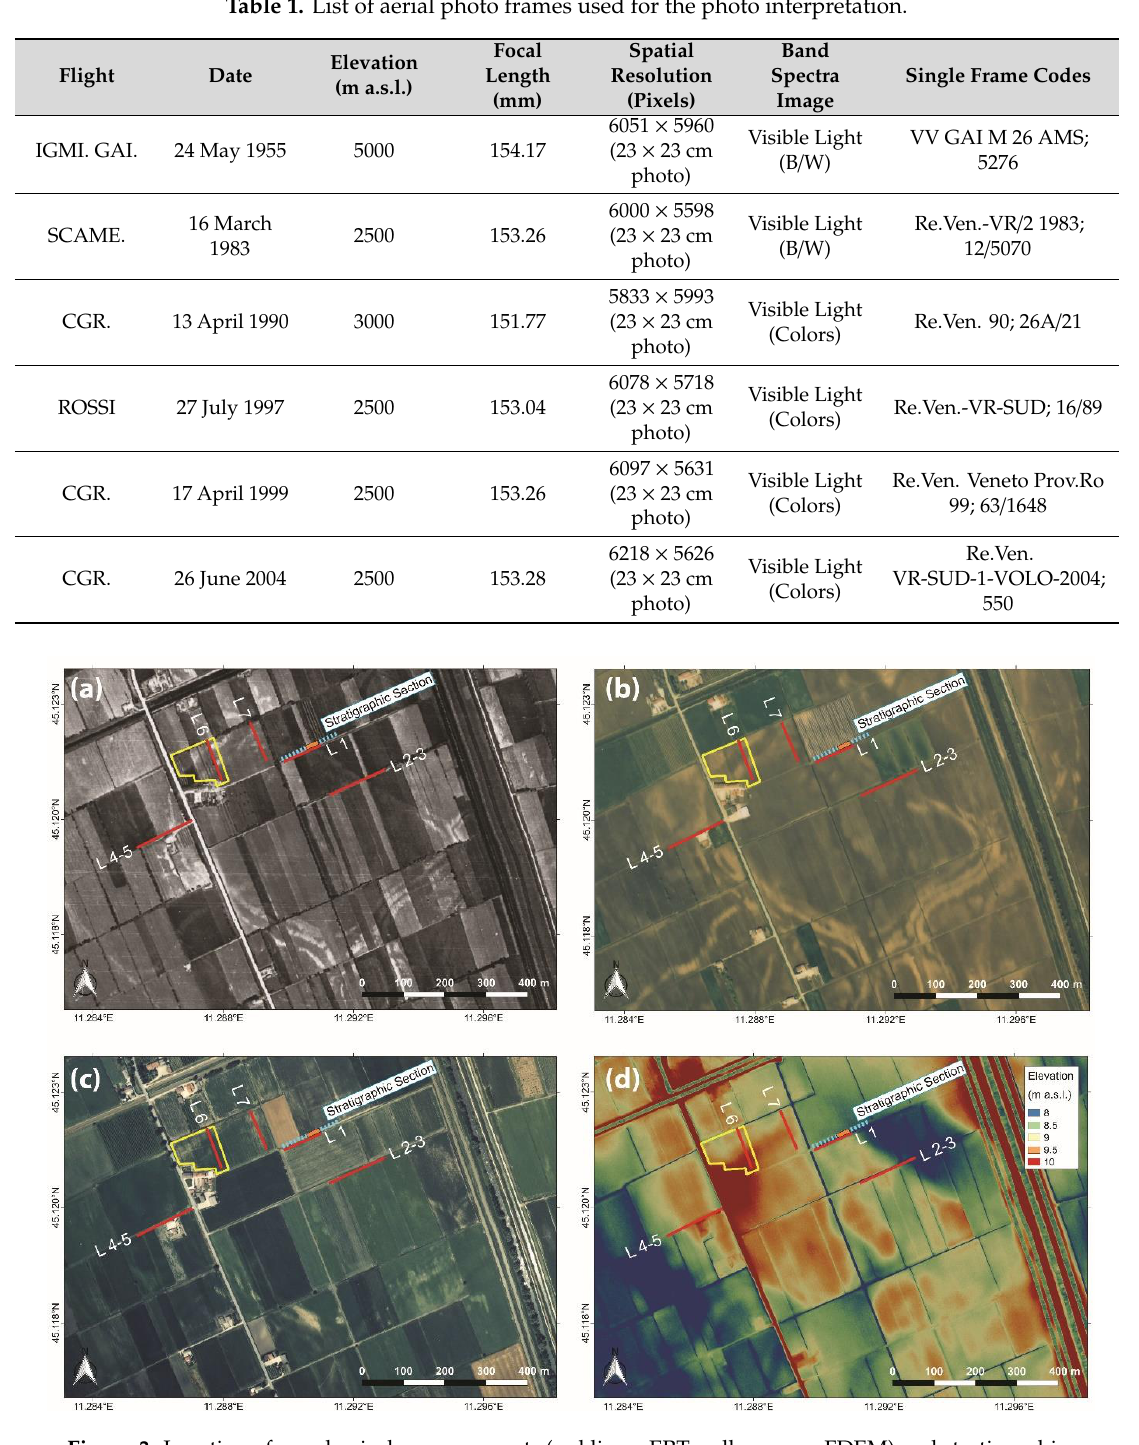
Figure 3. Location of geophysical measurements (red lines: ERT; yellow area: FDEM) and stratigraphic section (dotted cyan line: stratigraphic section; orange line: segment intercepting the